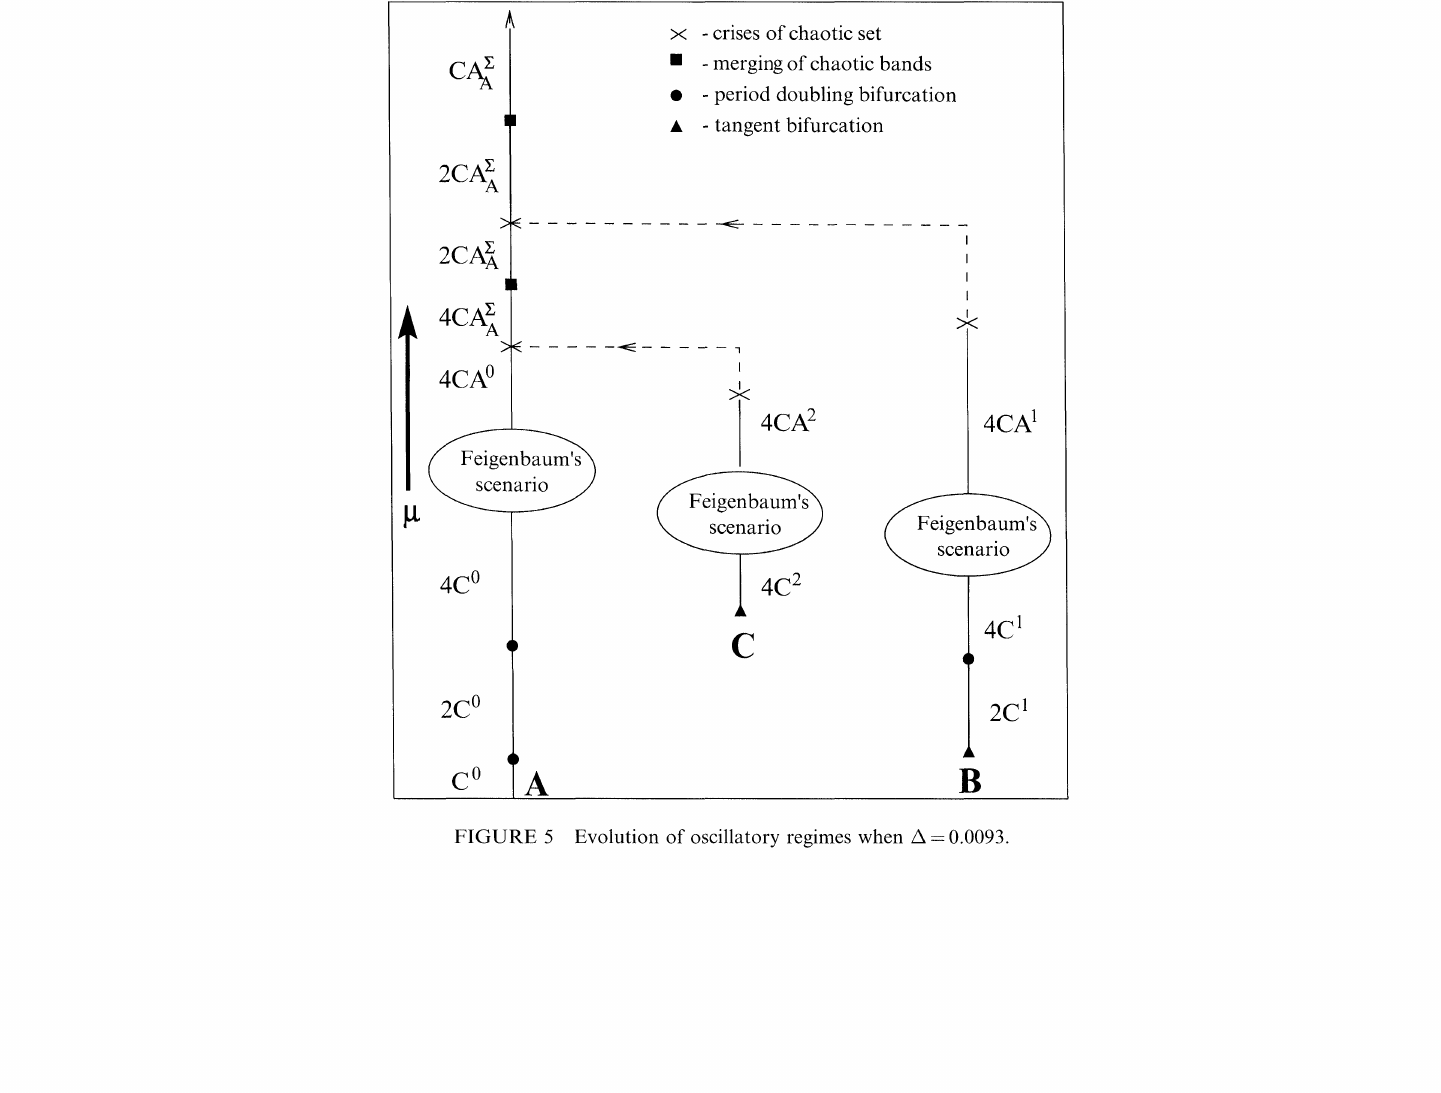
FIGURE 5 Evolution of oscillatory regimes when A